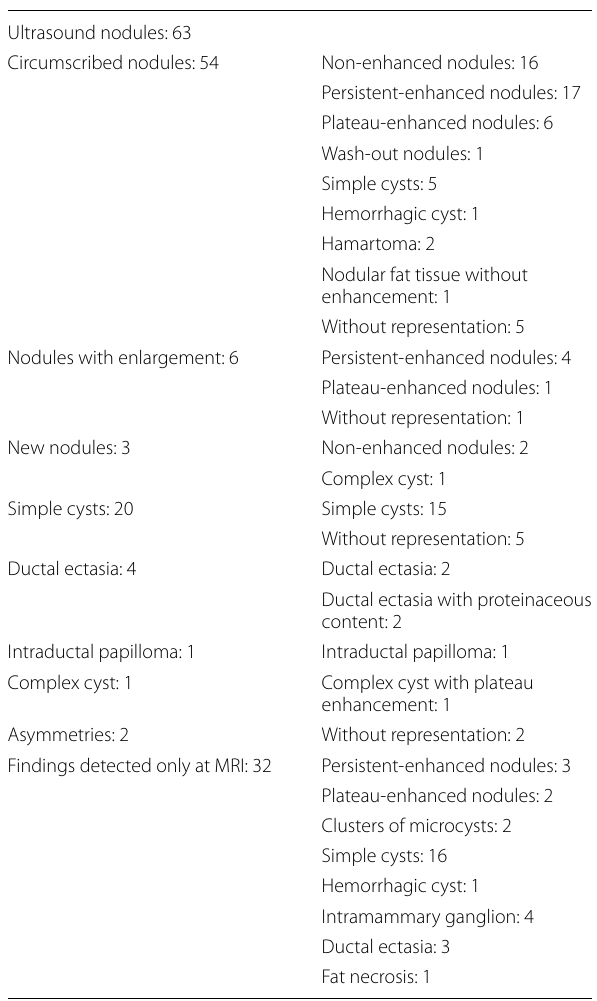
Table 7 Ultrasonography findings versus DCE characterization of BI‑RADS 4A patients Appearance of ultrasound findings DCE characterization